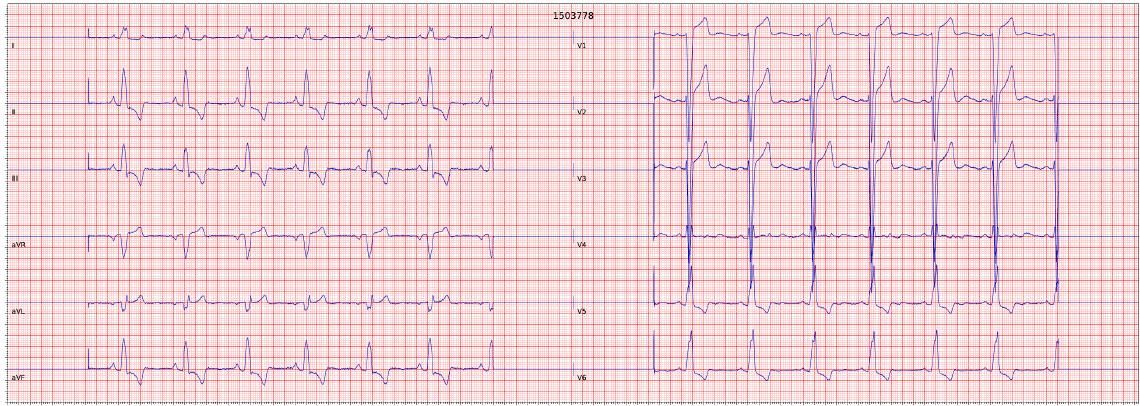
Figure 4. A 12-lead ECG of a patient with exam_id of 1503778 diagnosed for LBBB